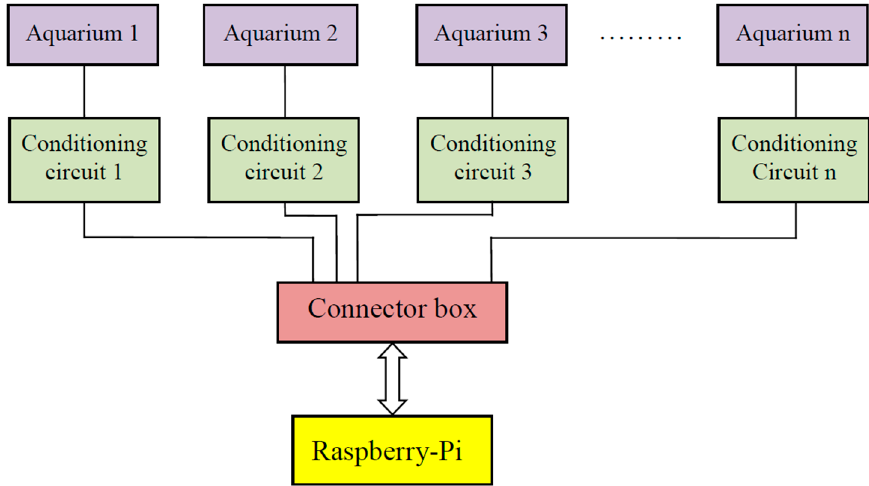
Figure 1. Block diagram of the monitoring system.